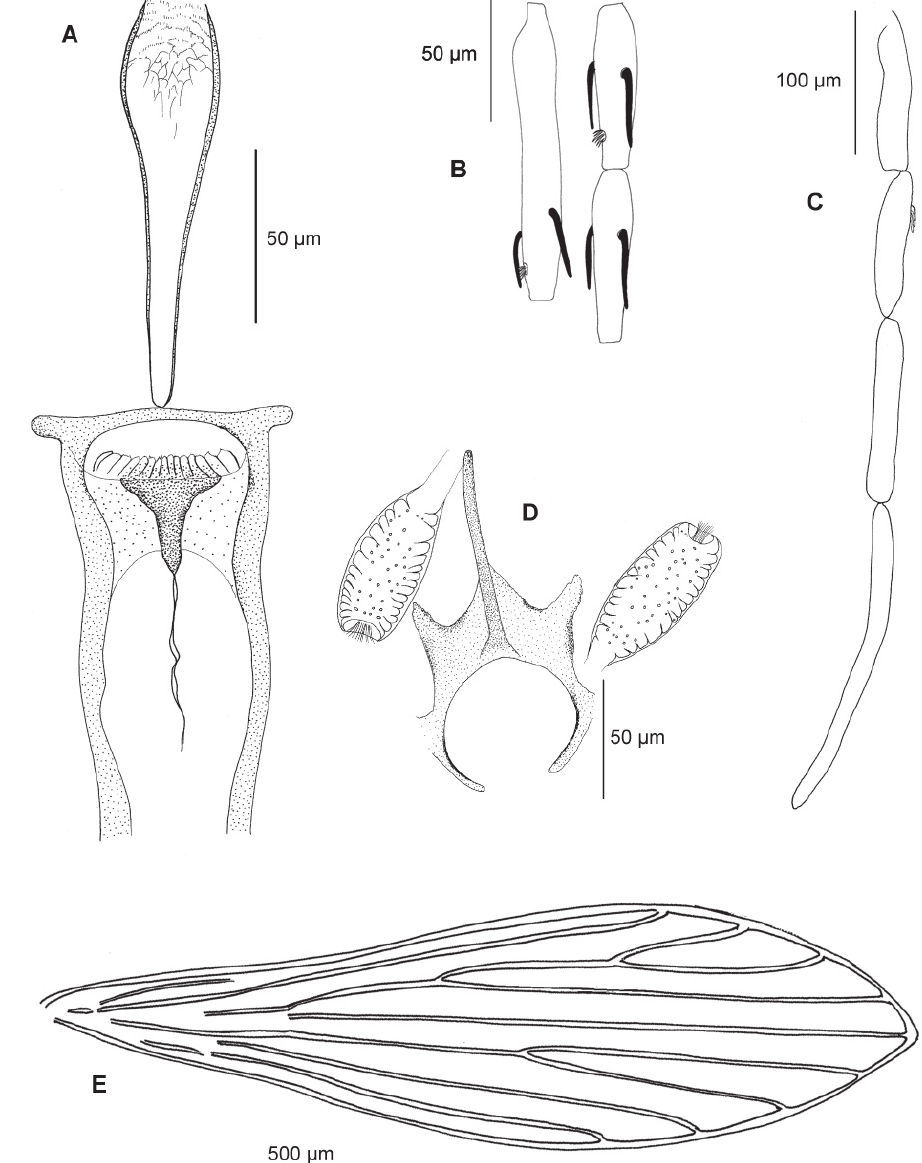
Fig. 3. – Sergentomyia goodmani